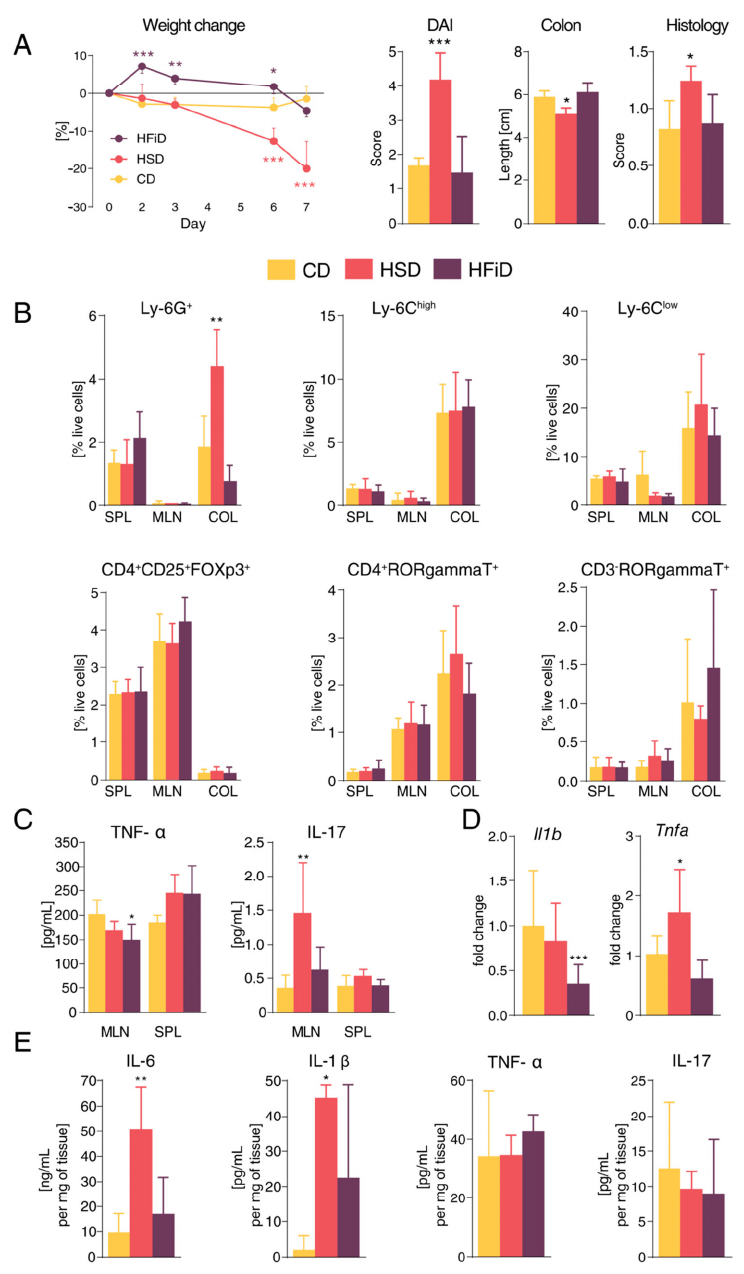
Figure 2. Simple sugars significantly modify colitis course and mucosal immune response. ( A ) Weight change during dextran sodium sulfate treatment, final disease activity score (DAI), colon length, and histology score. ( B ) Percentage of live cells from spleens, mesenteric lymph nodes, and colons measured by flow cytometry. ( C ) TNF- α and IL-17 production in cell suspensions from mesenteric lymph nodes and spleens stimulated with anti-CD3 / anti-CD28 antibodies. ( D ) The mRNA expression of pro-inflammatory cytokines in colon. ( E ) Cytokines measured in tissue culture of colon biopsies from diseased mice. Data presented are from one representative experiment out of three, n = 5–8 mice per group. Means significantly di ff erent from CD were calculated. The weight loss was analyzed by two-way ANOVA with Bonferroni post hoc test and other parameters by one-way ANOVA with Dunnett’s multiple comparison test in a respective organ. Data are shown as mean ± SD. * p < 0.05; ** p < 0.01; *** p < 0.001. CD, control diet; HSD, diet rich in simple carbohydrates; HFiD, diet rich in fiber; SPL, spleen; MLN, mesenteric lymph nodes; COL,